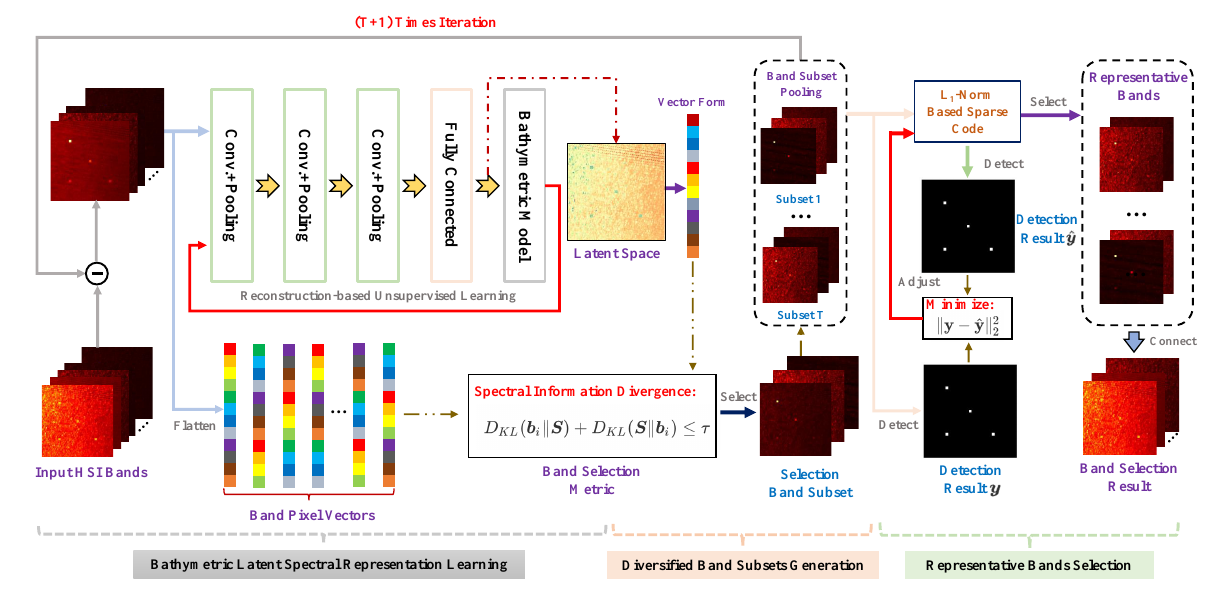
Figure 3. The flowchart of the proposed